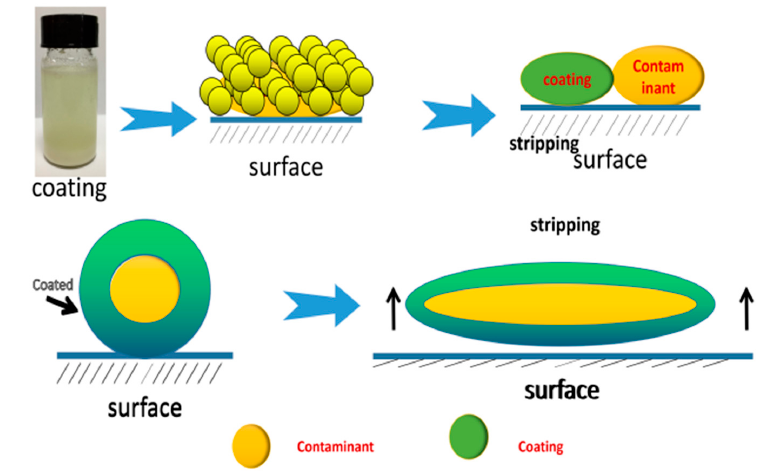
Figure 1. Diagram of strippable decontaminant.